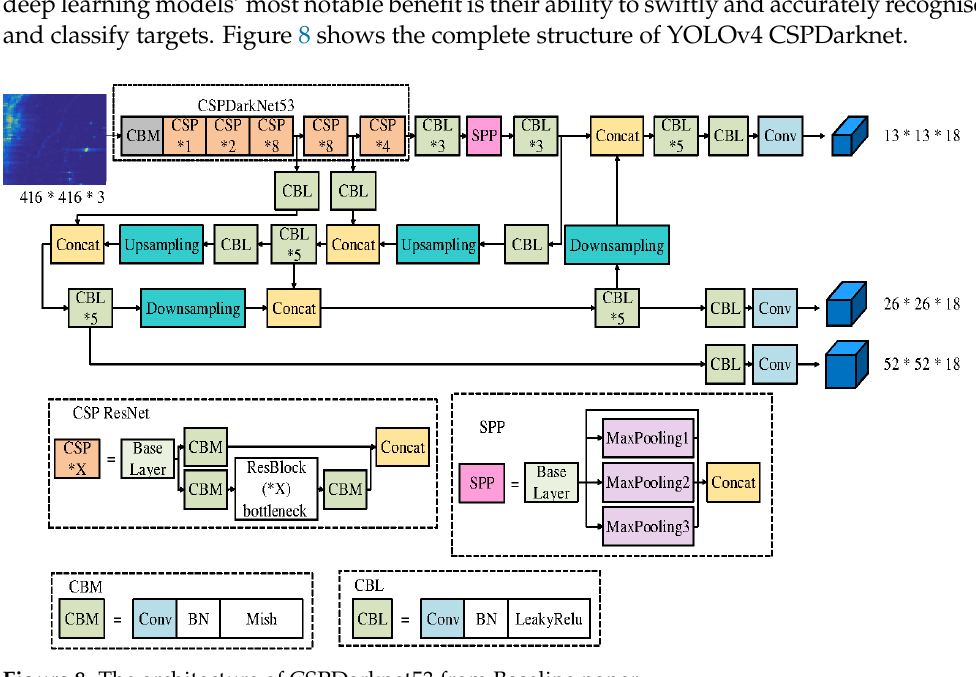
Figure 8. The architecture of CSPDarknet53 from Baseline